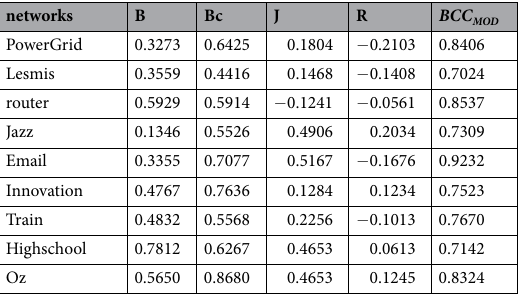
Table 3. Spearman correlation coefficients between the ranking scores and the relative differences of real infected scale R s . All results are averaged over 200 independent implementations under μ / μ c =